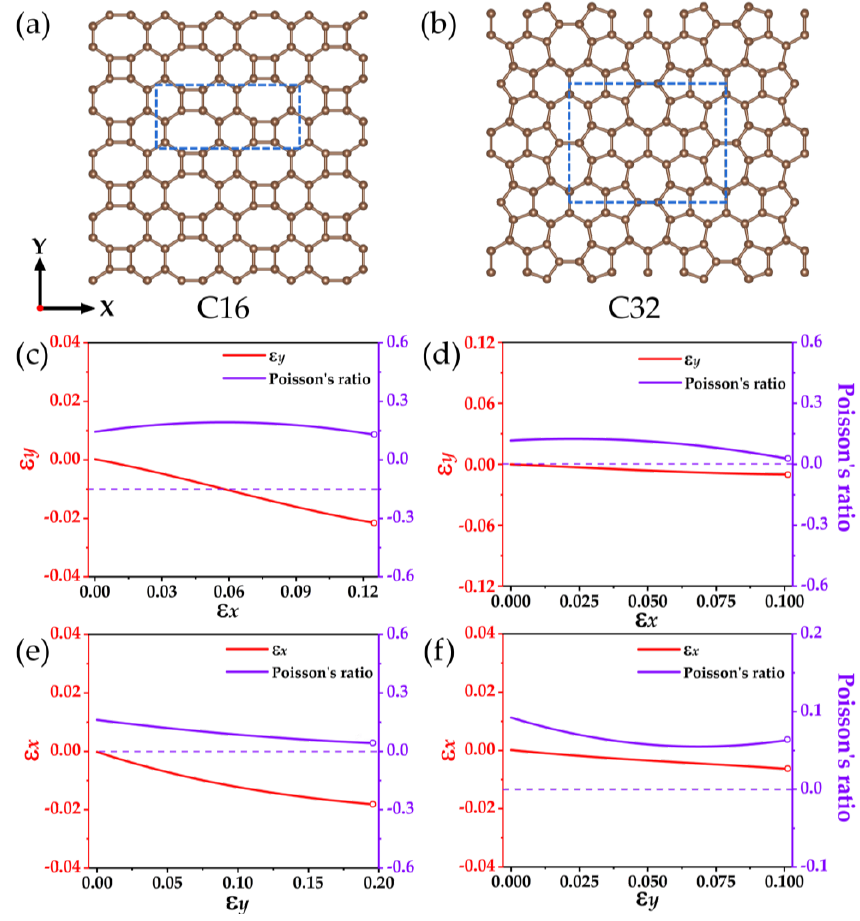
Figure 5. Structures and mechanical properties of C16 and C32. Two structures of C16 and C32 are shown in ( a , b ). The mechanical responses of C16 and C32 are shown in ( c , e ) and ( d , f ). Red lines represent the response of the driven strain under the uniaxial strain along the x - and y -axis, respectively, and purple lines represent the Poisson’s ratio under the uniaxial strain along the x - and y -axis, respectively.